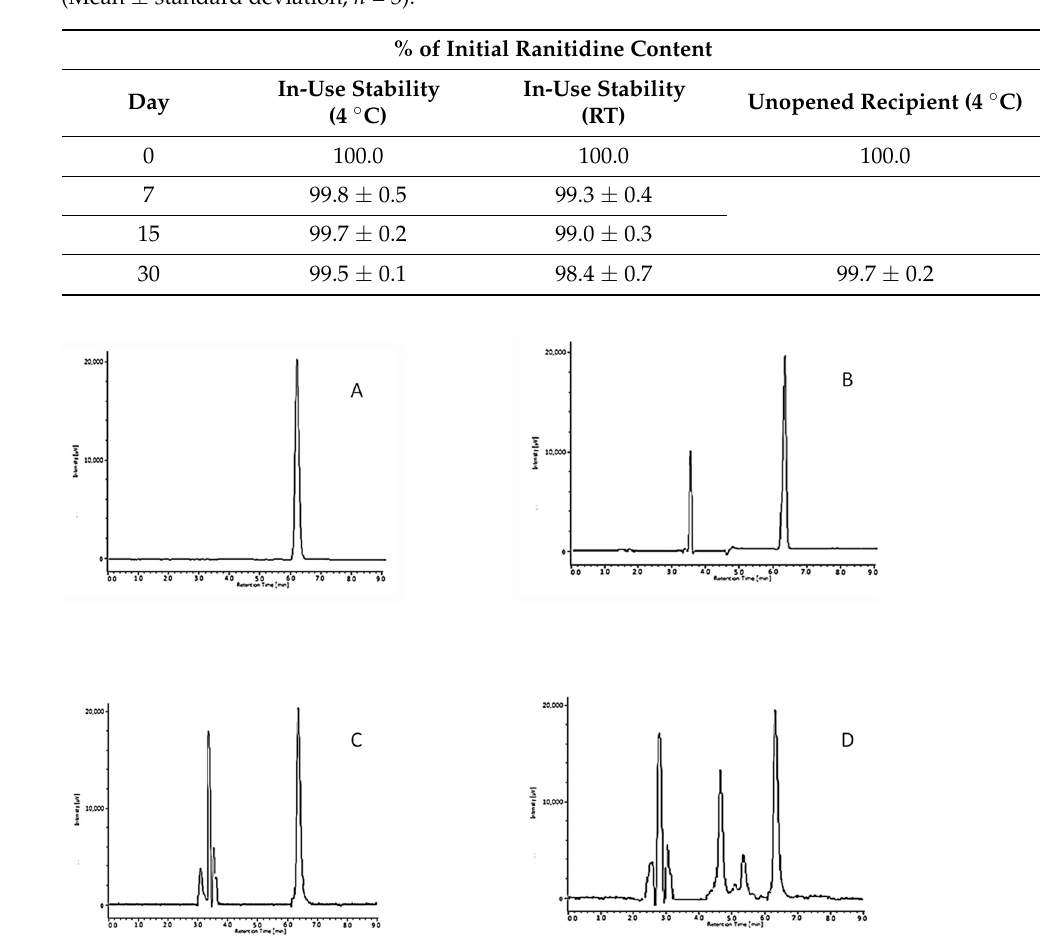
Figure 2. Chromatographic runs of Ra-HCl after 30 days preserved at 4 °C ( A ), after 30 days open daily preserved at 4 °C ( B ), after 30 days preserved at room temperature ( C ) and after 30 days open daily preserved at room temperature ( D ).